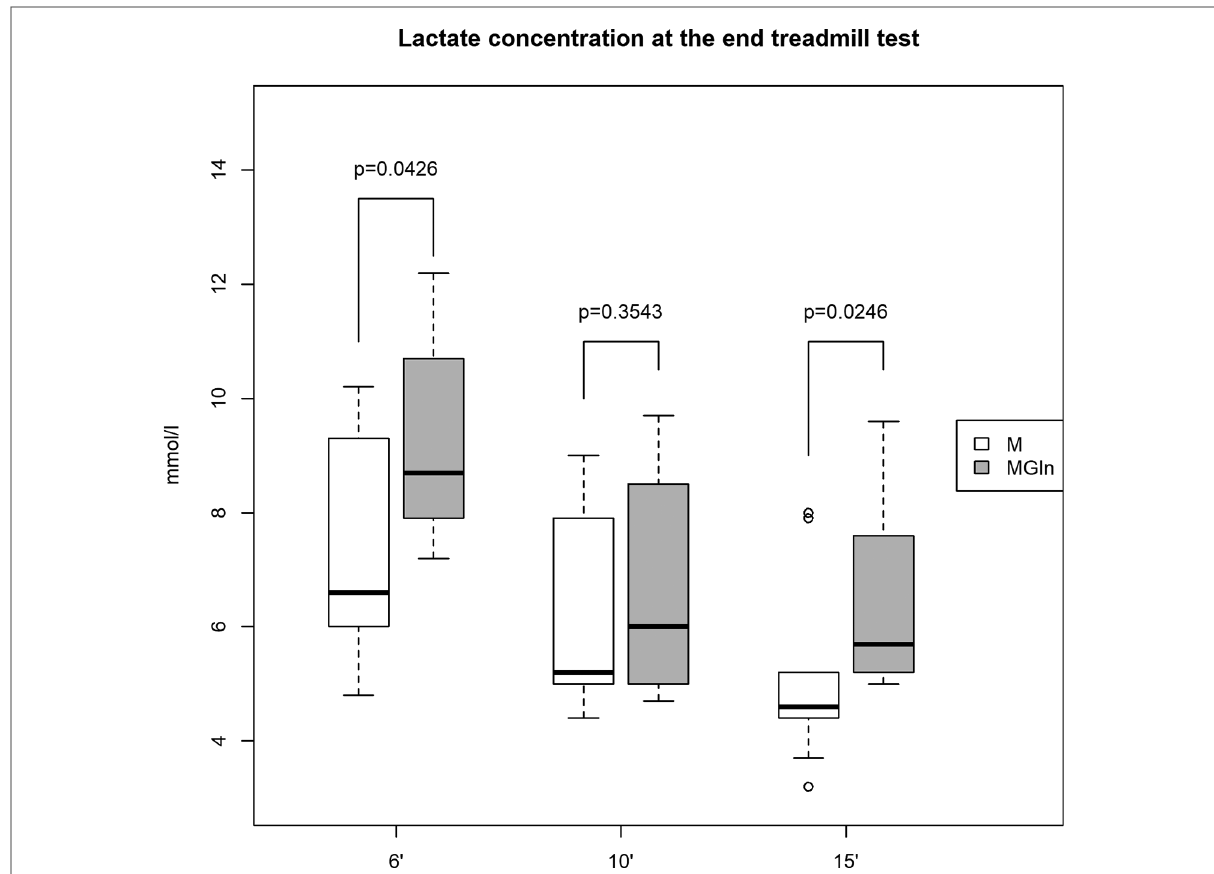
FIGURE 2 Plasma lactate concentrations in athletes supplemented with maltodextrin (M) or maltodextrin plus hydrolyzed protein enriched with glutamine (MGln). Plasma lactate concentration (mmol/L) at 6, 10, and 15 min after exercise in athletes supplemented with M or MGln. For both tests, a signi fi cance level of 0.05 was